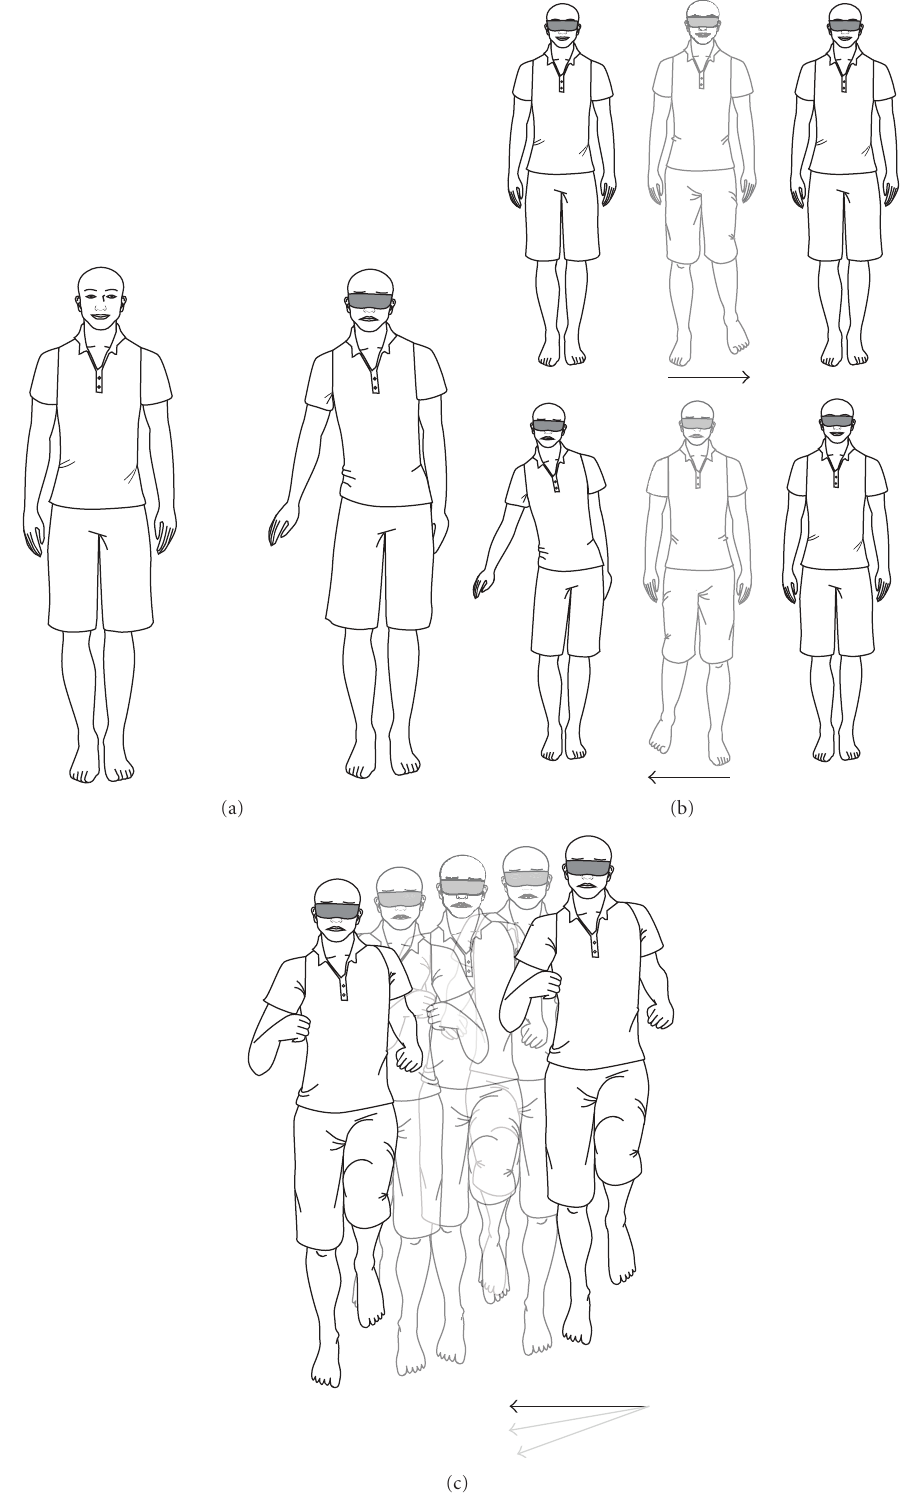
Figure 1: The sideways stepping test. (a) The patient is asked to stand with feet together and hands by the sides. They are then asked to close eyes or are blindfolded. A positive test is an involuntary lean to one side and hip sway. Sometimes the hand is lifted out to compensate. (b) The patient is asked to take two steps sideways and stop, first with eyes open and then with eyes closed or blindfolded. A positive test is an involuntary sway and/or taking a step to compensate. (c) The patient is asked to jog on the spot for 30 seconds with eyes closed or blind-folded. There should be no deviation. A positive test is an involuntary drifting, to one side, and sometimes forward or back. A positive test should be repeatable on subsequent